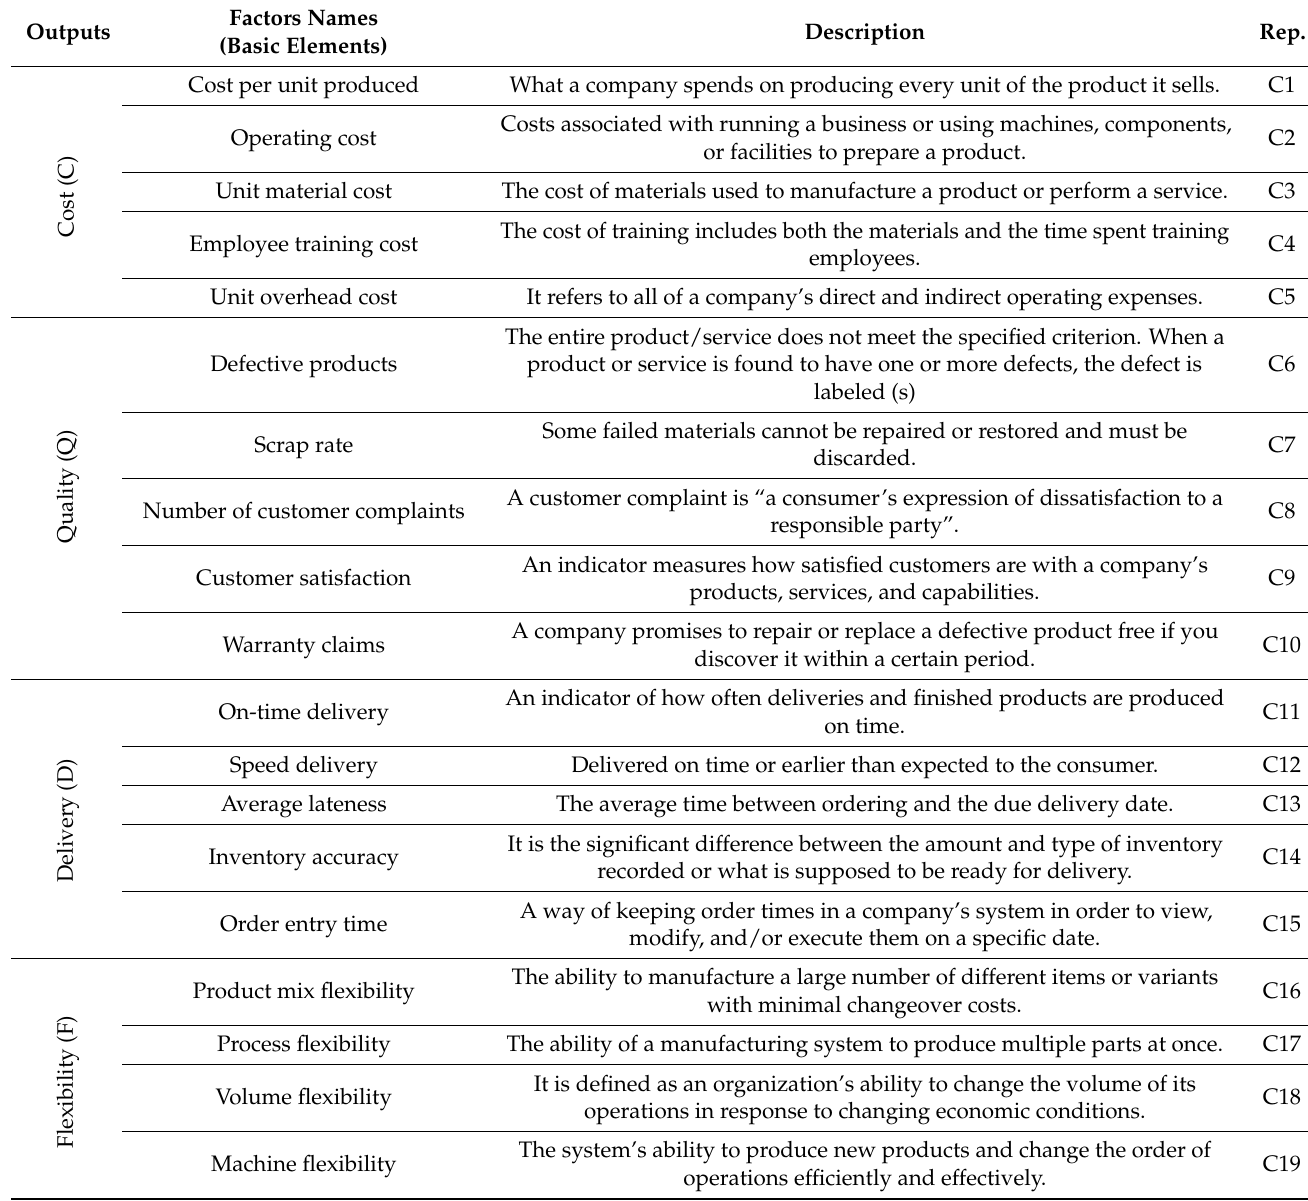
Table 1. Factors of manufacturing strategies in the adoption of Industry 4.0